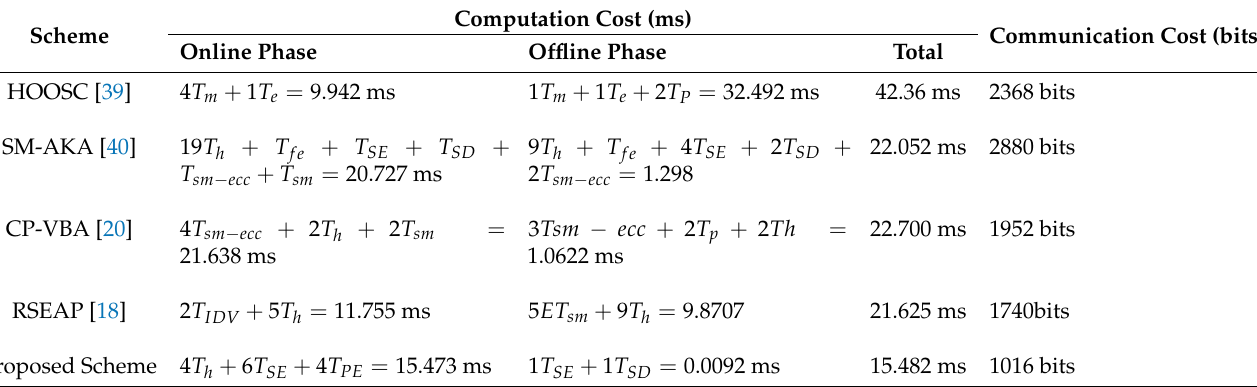
Table 5. Computation and communication costs